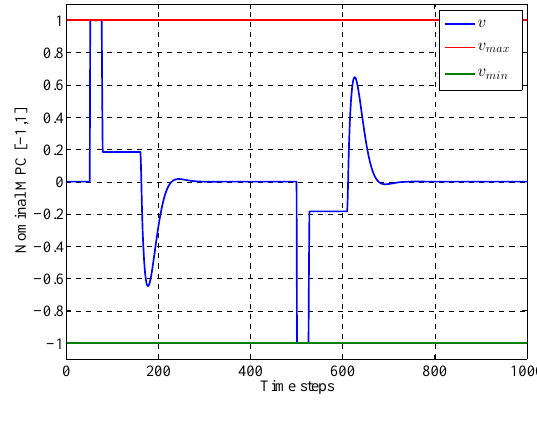
Figure 5: Nominal MPC